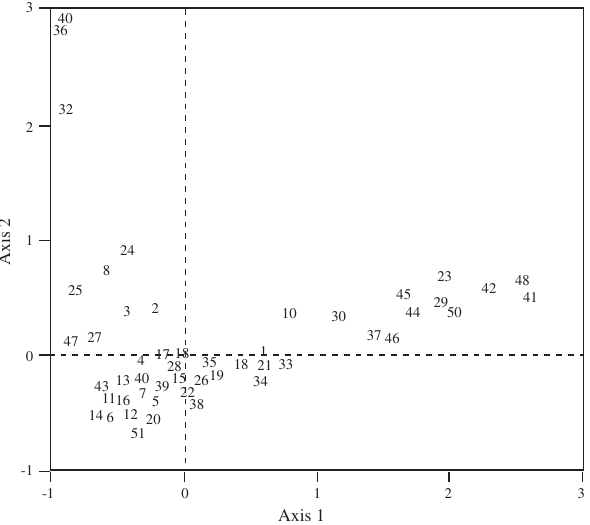
F IG . 7. – Species representation in the two first axes derived from a factorial correspondence analysis. Numbers correspond to species as indicated in Table